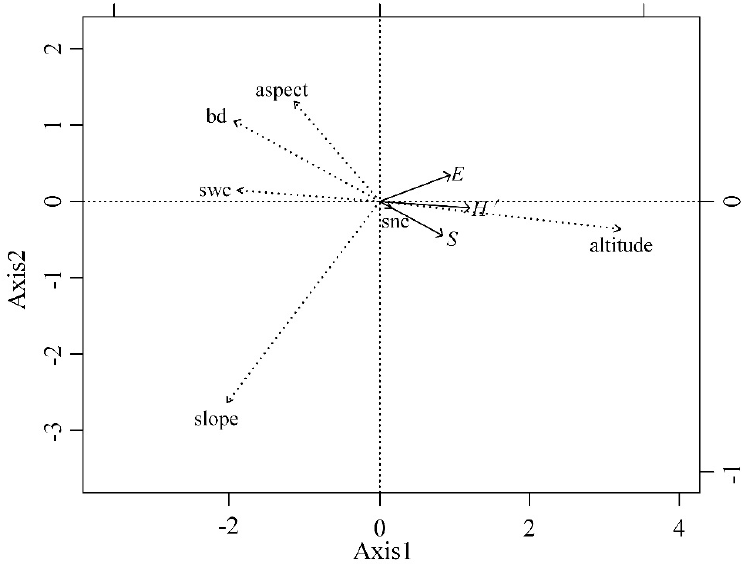
Figure 3. Biplots diagram of redundancy analysis (RDA) on tree species diversity constrained by topographic and water conservation data. S (observed richness), H ′ (Shannon diversity index), E (Shannon evenness index) are response variables (solid line with arrow). Altitude, aspect, slope, bulk density (bd), soil water content (swc) and soil non-capillary porosity (snc) are as explanatory variables (dashed line with arrow).